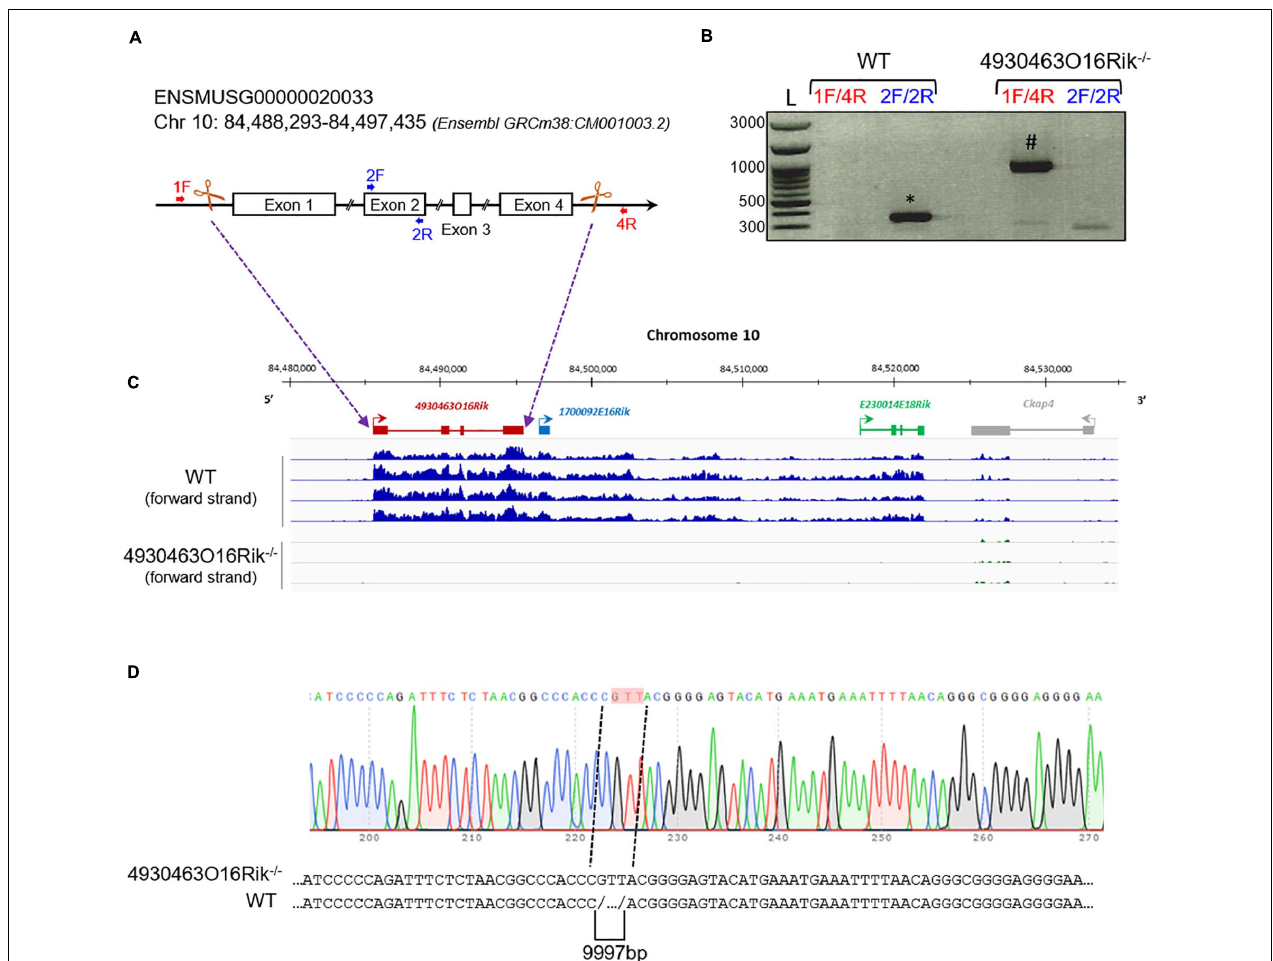
FIGURE 4 | Deletion of the 4930463O16Rik gene in the mouse. (A) Schematic design of CRISPR/Cas9 deletion of the 4930463O16Rik gene with the suppression of four exons and three introns. The white boxes and lines represent exons and introns, respectively. (B) PCR genotyping on DNA of WT and 4930463O161Rik − / − mice. The primer pairs used 1F/4R (located in 5 (cid:48) of exon 1 and in 3 (cid:48) of exon 4 of the 4930463O16Rik gene, respectively) or 2F/2R (located in the exon2 of 4930463O16Rik ) to determine the genotypes of the mice. Results showed the following amplicon sizes: (*) 352 bp with the 2F/2R primers in WT (no amplification in mutant mice); (#) 935 bp with the 1F/4R primers in 4930463O161Rik − / − mice (no amplification in WT mice under the PCR conditions used). (L) DNA ladder. (C) Transcription of the forward strand of chromosome 10 around the 4930463O16Rik gene with RNA-seq coverage (BigWig format representation) in WT (top blue tracks) and 4930463O16Rik − / − (bottom tracks) mouse P18 testes. A continuous (WT) or very low transcription ( 4930463O16Rik − / − ) was observed from 4930463O16Rik to E230014E18Rik genes. (D) Electrophoregram of 4930463O16Rik − / − mouse genomic DNA showing 9997 bp deletion and the insertion of three nucleotides (GTT, highlighted in